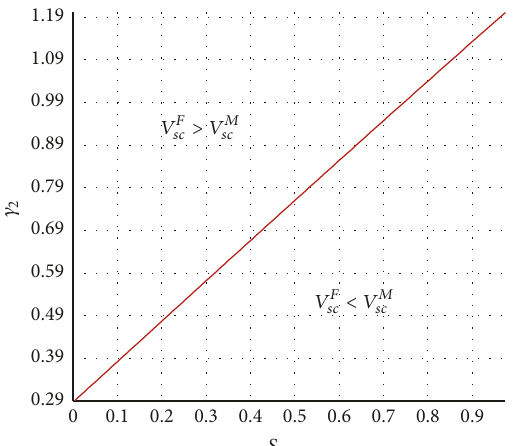
Figure 5: The comparison of the whole supply chain’s profits in terms of 𝛾 2 and 𝑆 .